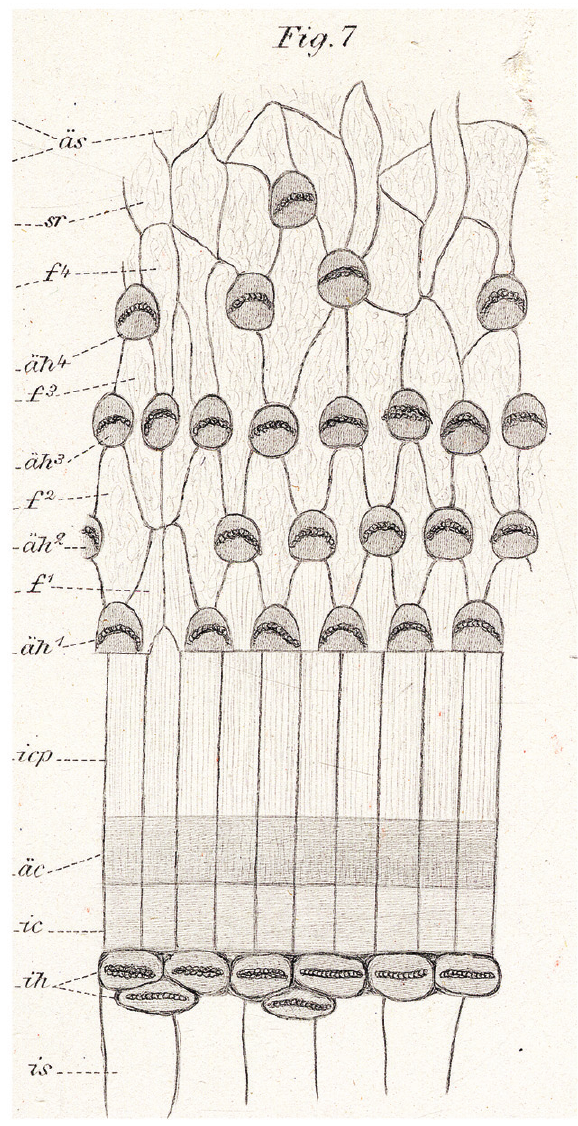
Figure 1. Surface pattern of the human cochlea (from Retzius 1884)